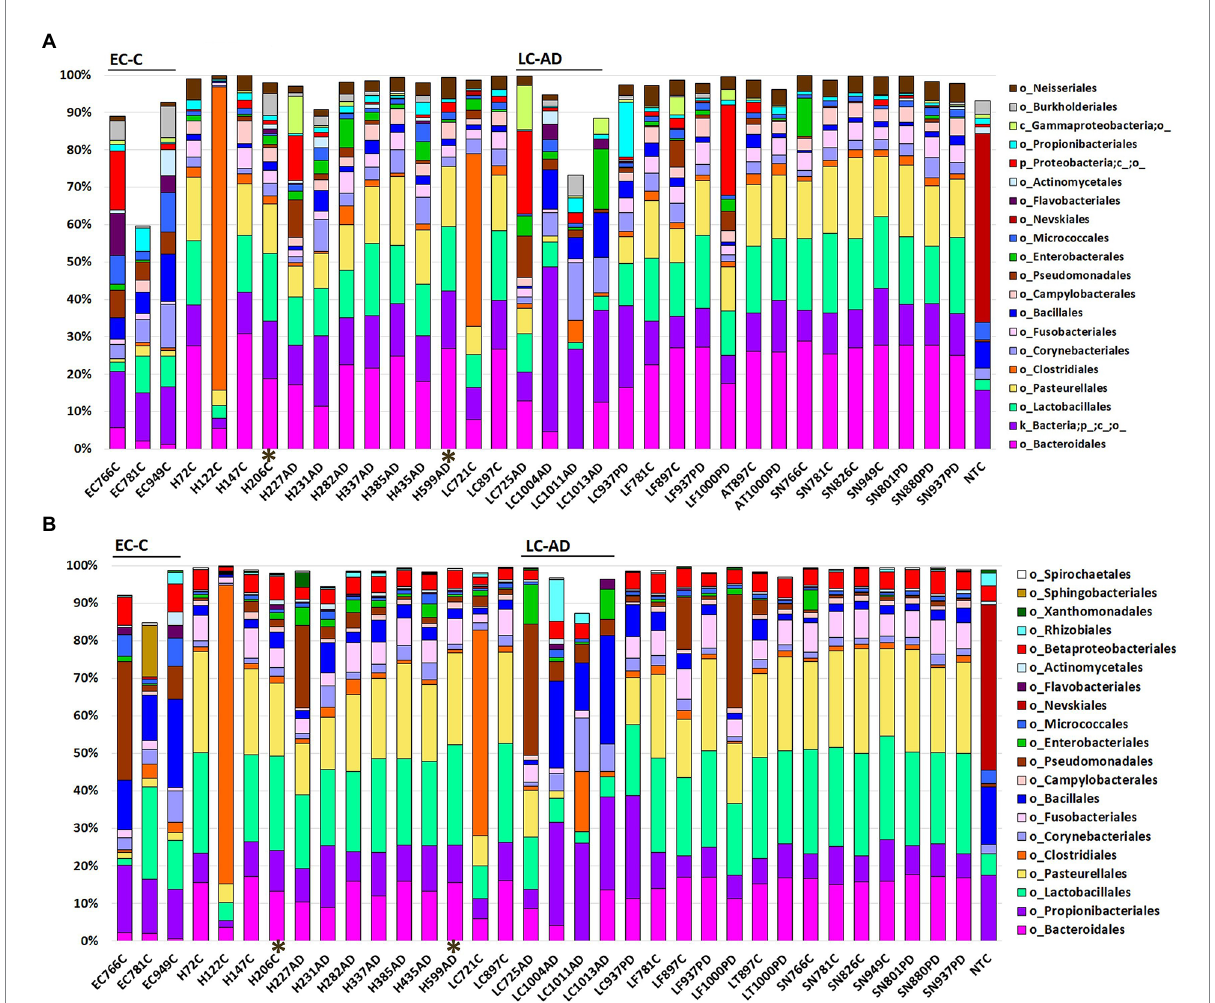
FIGURE 1 Bacterial population characteristics shown as relative abundance with profiles down to the order level for (A) OTUs taxonomically assigned by MED (Eurofins) and (B) OTUs taxonomically assigned by 97% OTU clustering as part of the statistical comparison pipeline (Novogene). AD, Alzheimer’s disease; C, control; PD, Parkinson’s disease. AT, anterior temporal pole (BA38); EC, entorhinal cortex (BA34); H, hippocampus; LC, locus coeruleus; LF, lower pre-frontal cortex (BA11); NTC-No Template Control. SN, substantia nigra. *Indicates samples with a post-mortem interval of > 40